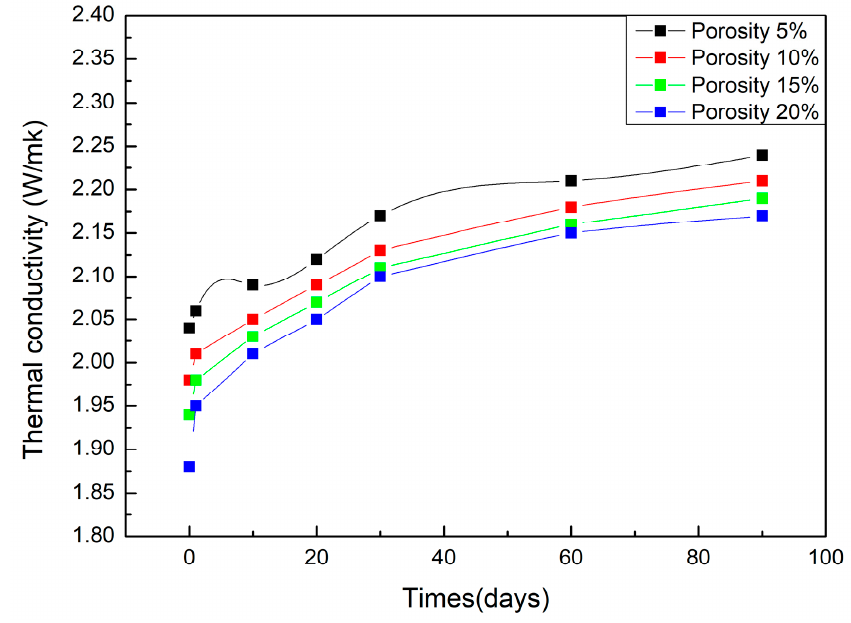
Figure 10. Variation of calculated thermal conductivity with different porosities at 1100 °C for different serving time.